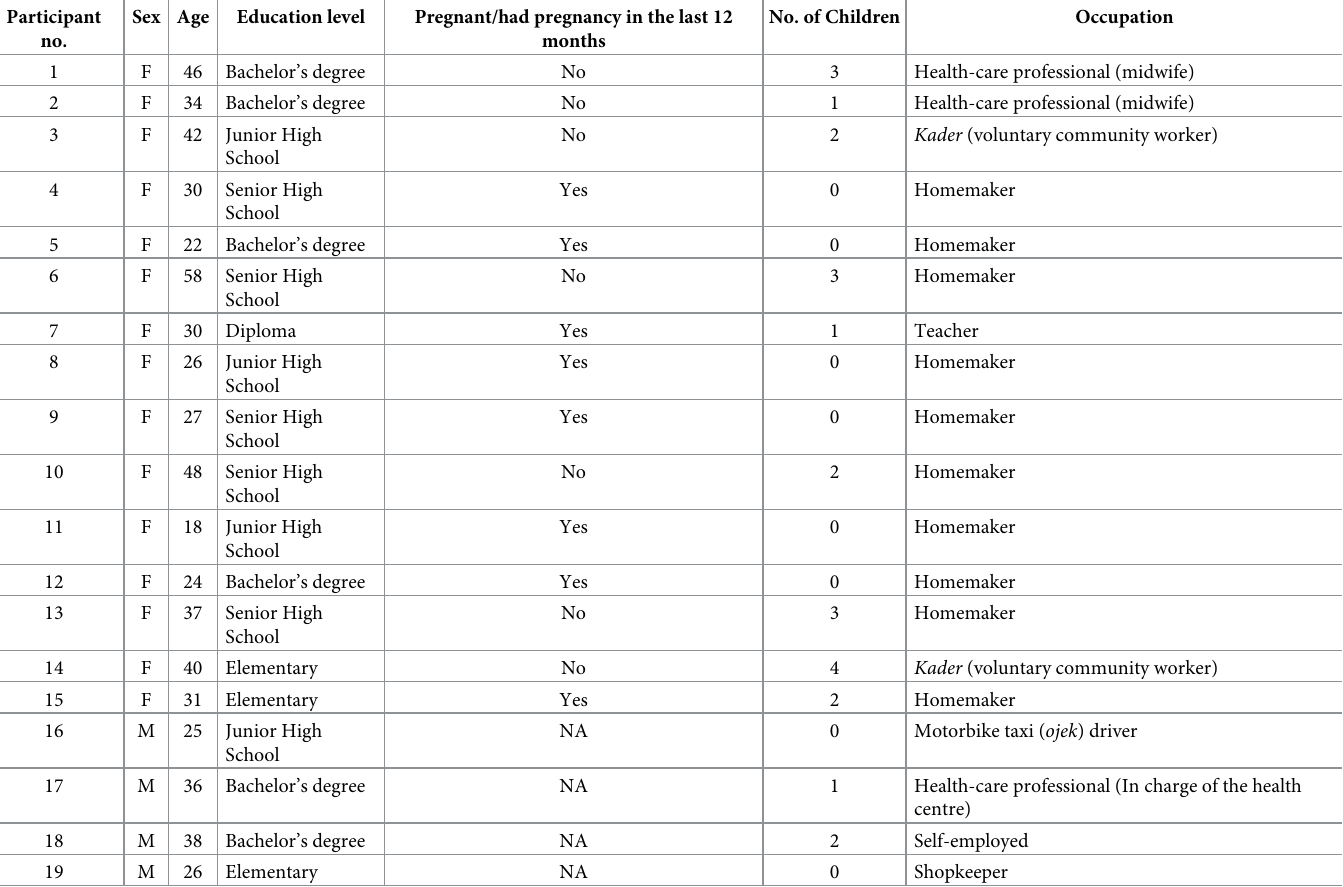
Table 1. Demographic information of the study participants. Participant